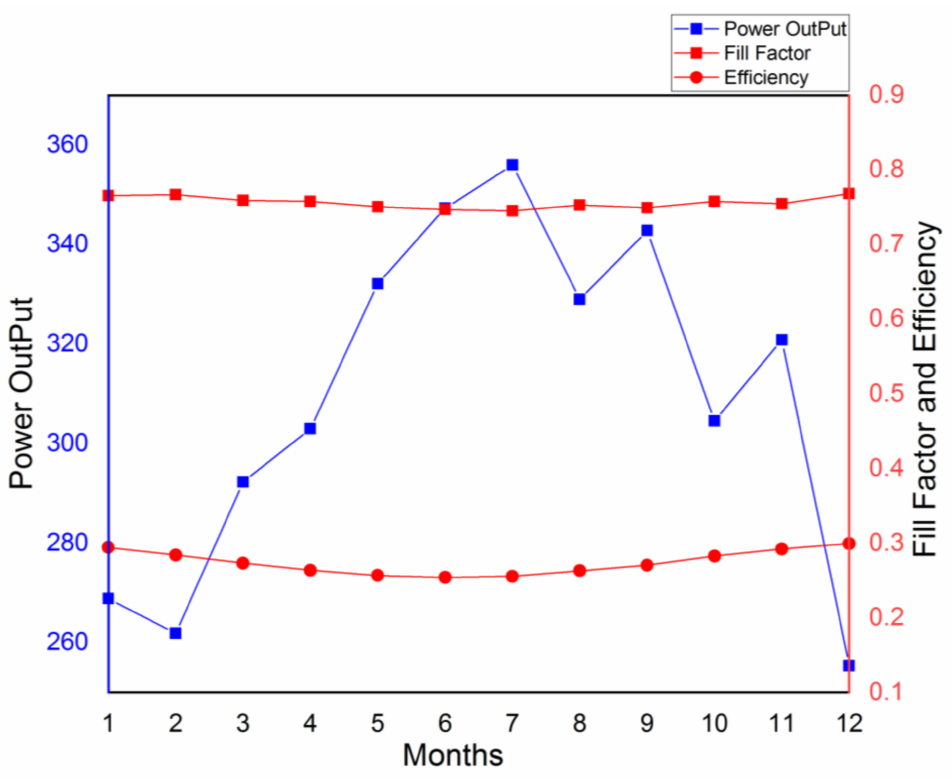
Figure 5. Power, efficiency, and FF at a fixed 5-degree tilt angle, by month.